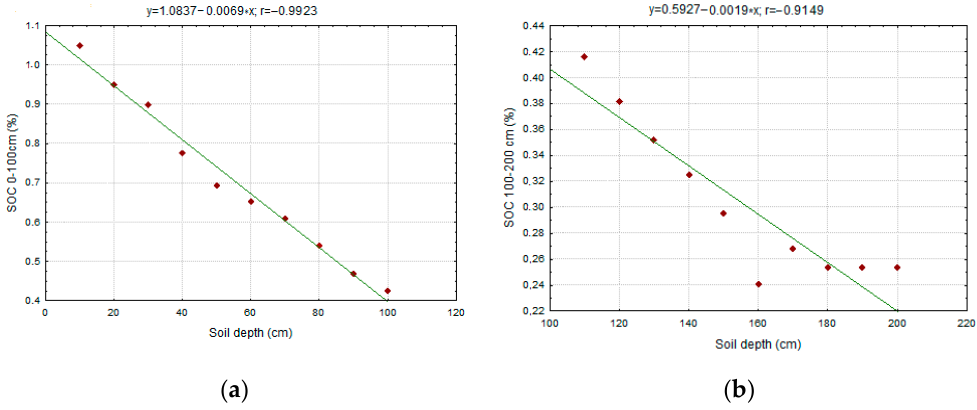
Figure 9. Regression analysis for the relationships between soil depth and SOC content in the soil profile of vineyards (<200 cm): ( a ) soil depth 0–100 cm and ( b ) soil depth 100–200 cm.